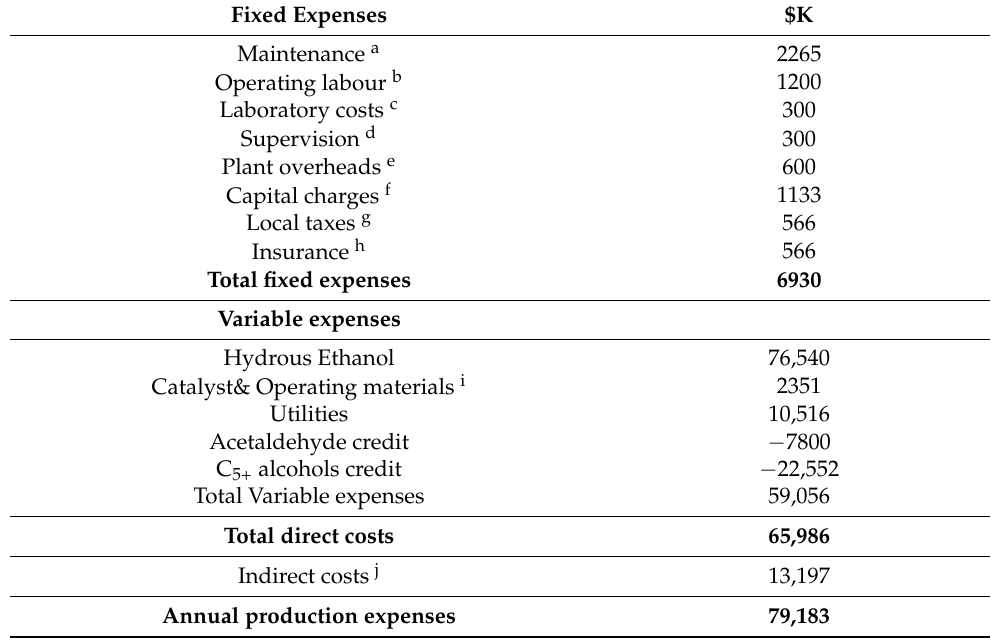
Table 9. Annual operational expenses for production of 80,000